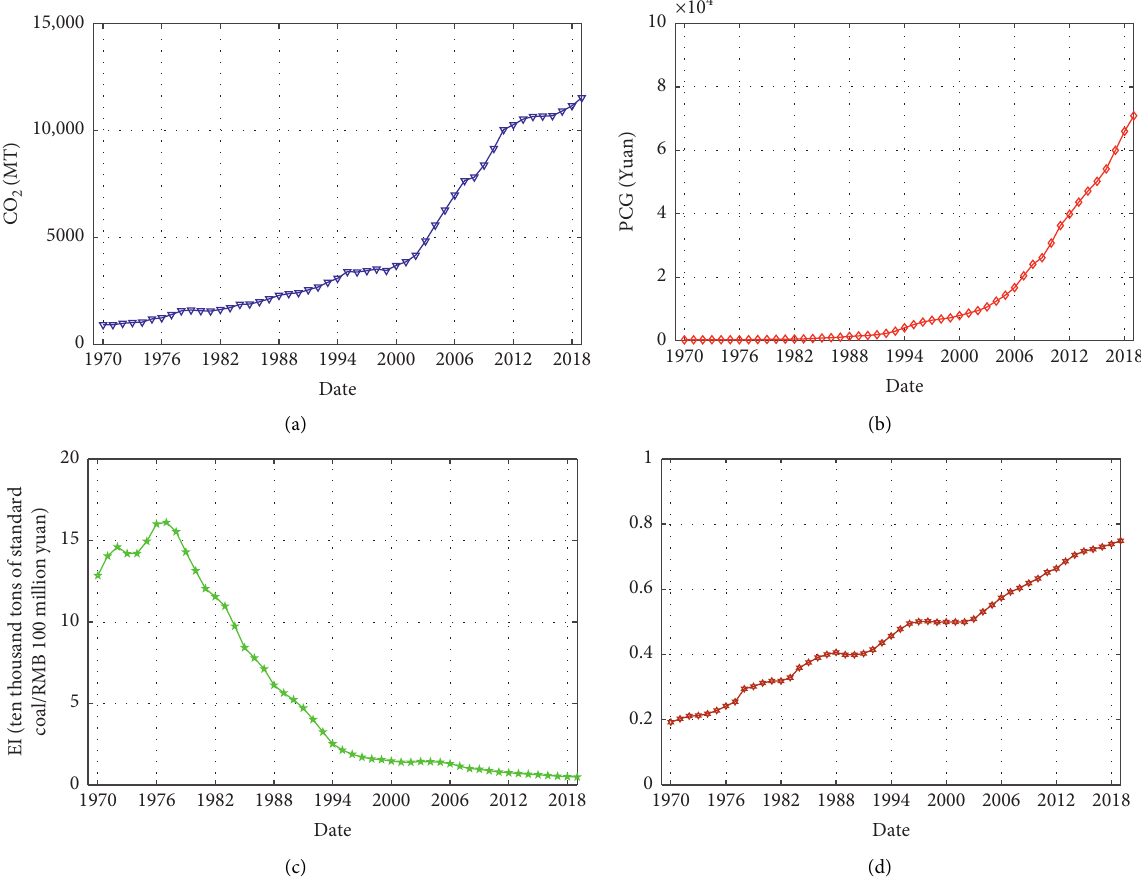
2 ; (b) PCG; (c) EI; (d) IAV.